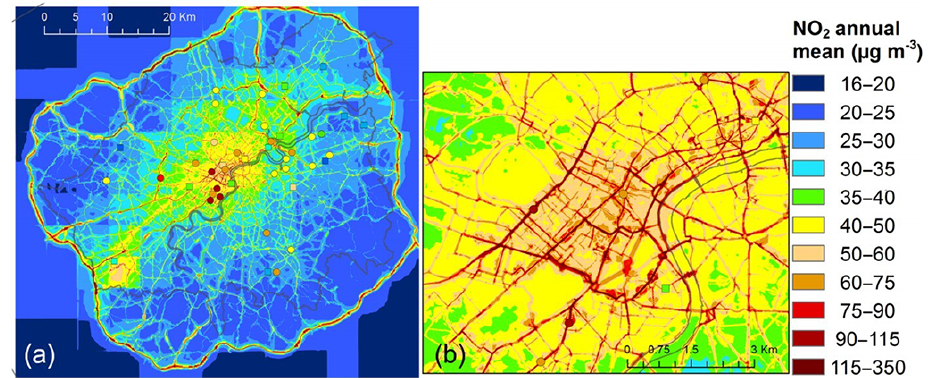
Figure 9. NO 2 annual average concentrations from the coupled ADMS-Urban–EMEP4UK model for (a) the whole of Greater London and (b) an area of central London. Monitoring data are overlaid as coloured symbols (Hood et al., 2018).